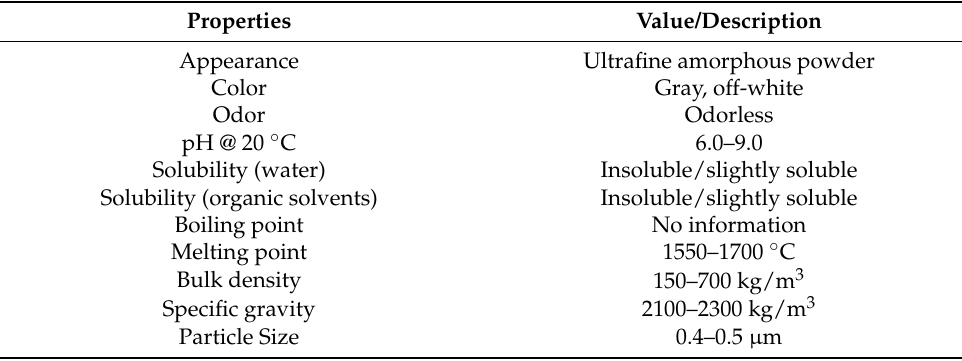
Table 2. Physical and chemical properties of silica